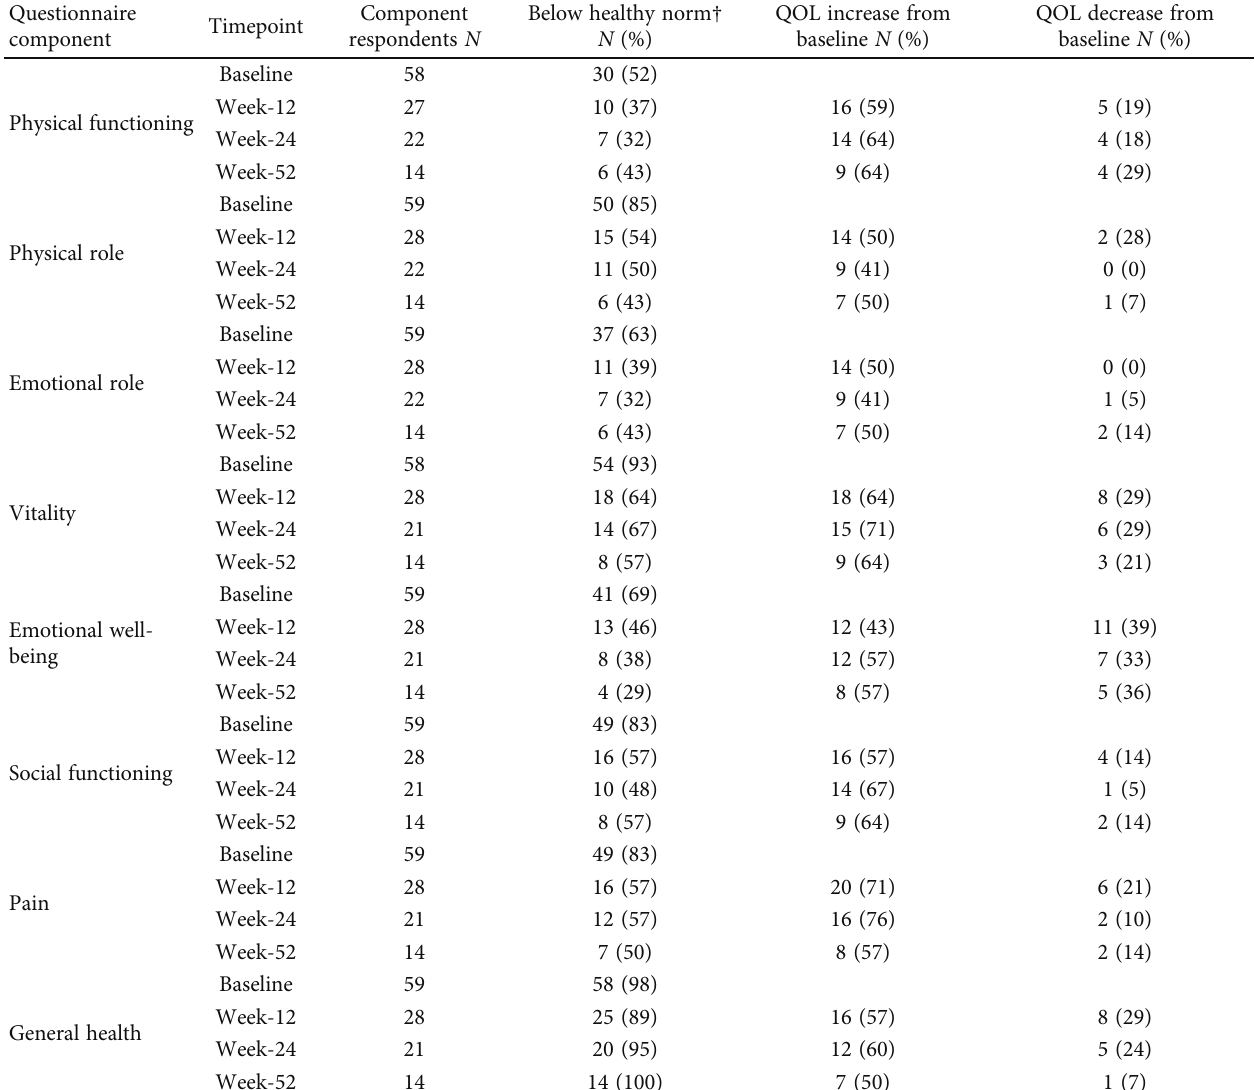
Table 4: Descriptive summary of short form-36 quality of life scores across baseline, week-12, week-24, and week-52 ( N = 59 ).